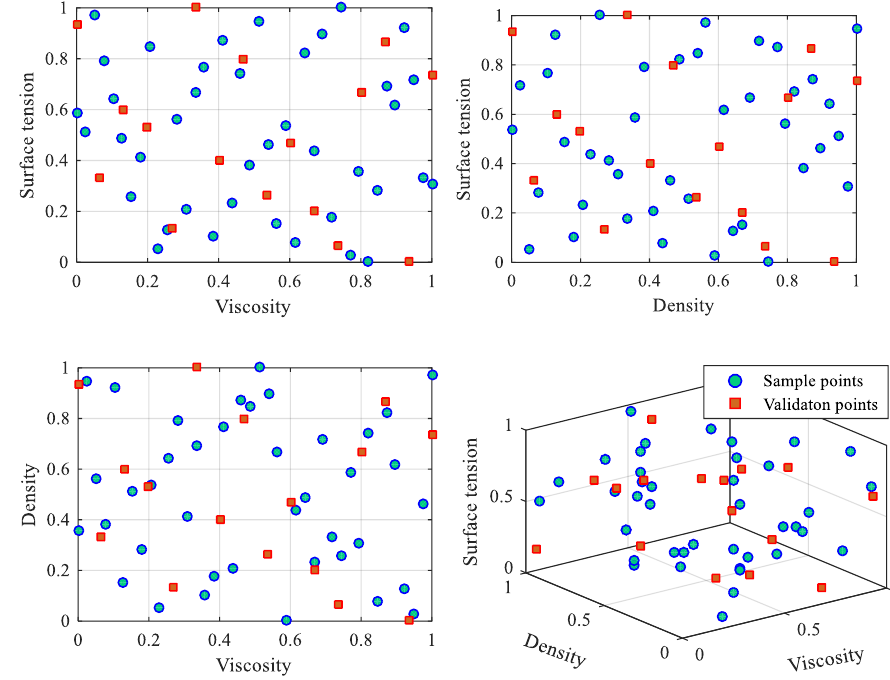
Figure 9. Sample points for surrogate modeling. Table 3. Surrogate model